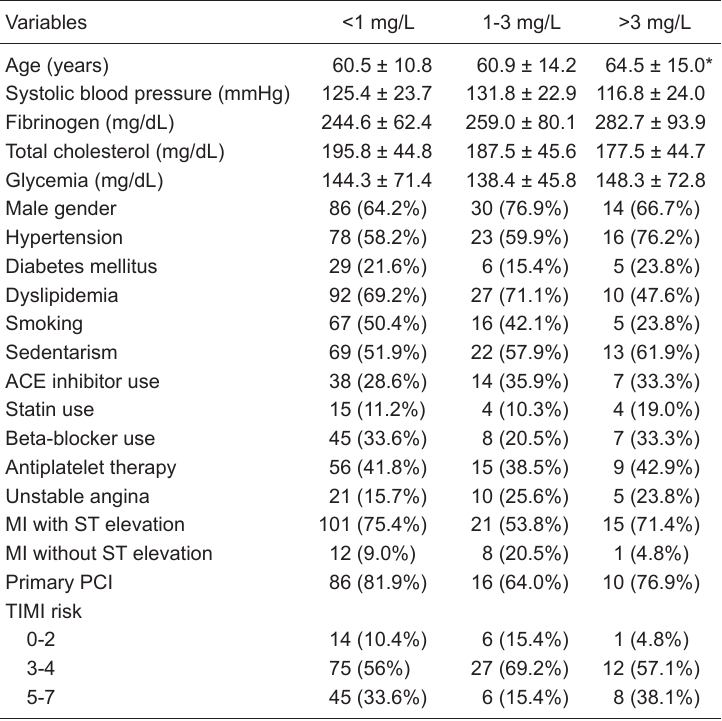
Table 1. Baseline characteristics of the patients according to C-reactive protein levels.